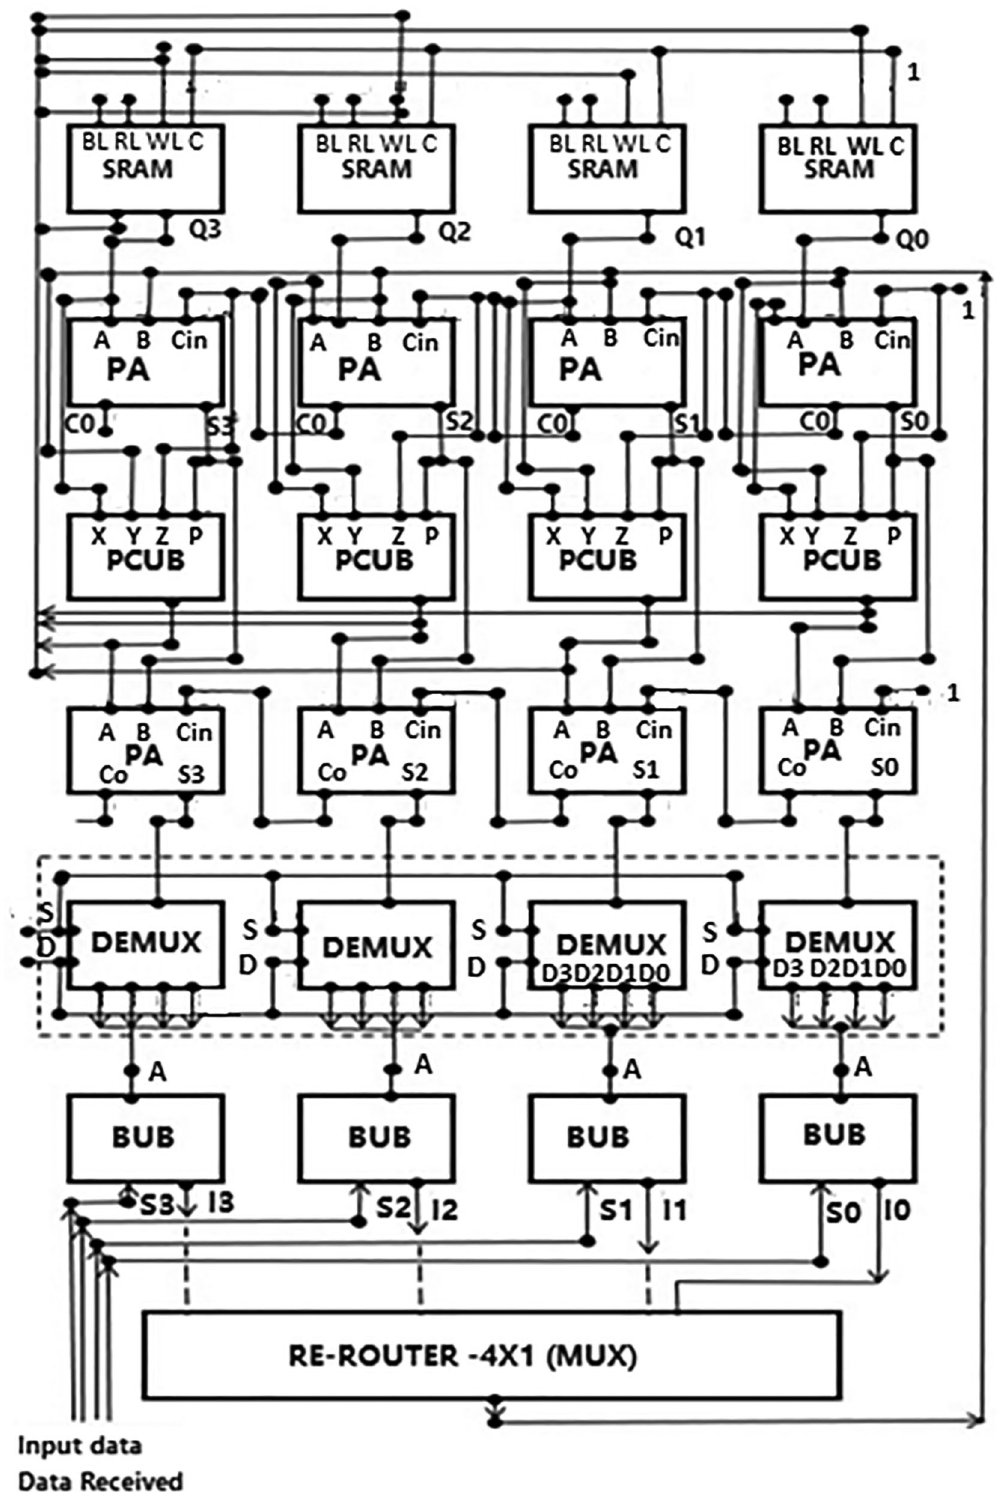
Figure 4. Proposed LDPC decoder